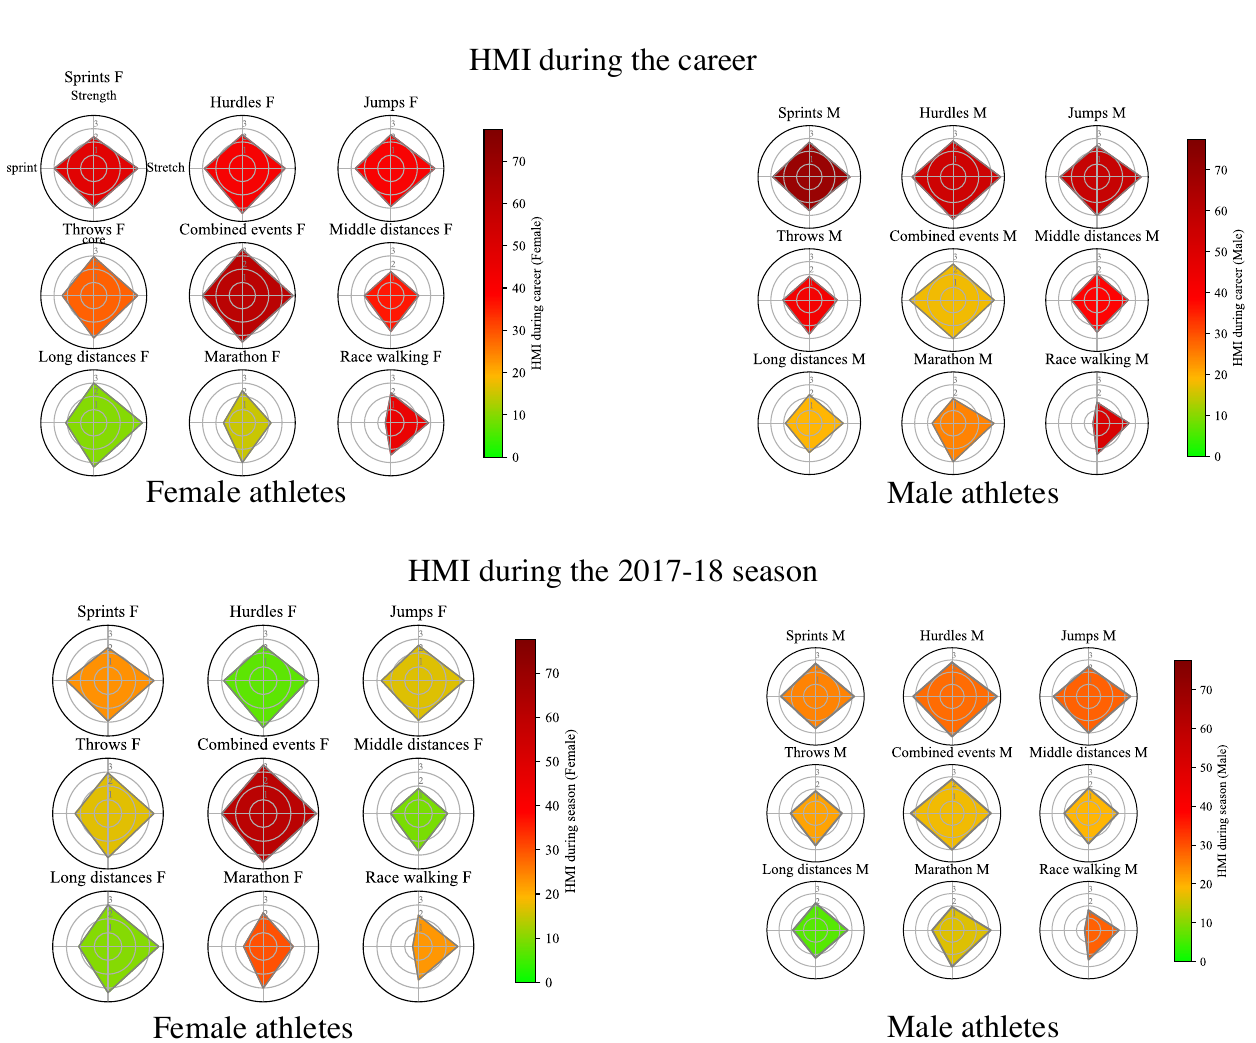
Figure 2. Profile of hamstring specific training according to sex and discipline, and with the history of HMI during the entire career (upper part of the figure) and during the 2017–18 season (lower part of the figure), in female (F) and male (M) athletes. The colours represent the prevalence of athletes with HMI in percentage, the targets present the mean score for athletes belonging to the sex × discipline category, for each of the four hamstring specific training types: hamstring strengthening ( up ), hamstring stretching ( right ), core stability conditioning ( down ), and sprint running at maximal intensity/velocity ( left